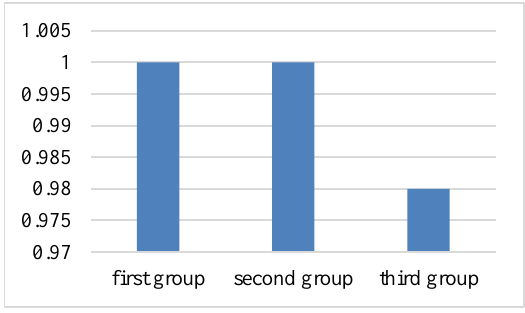
Figure 8. The angry mode in autistic children